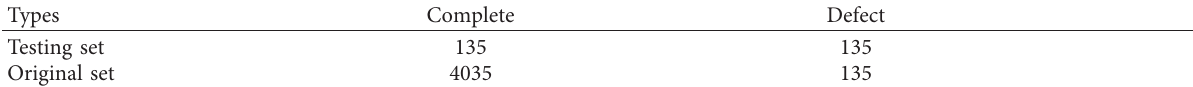
Table 1: The details of dataset for